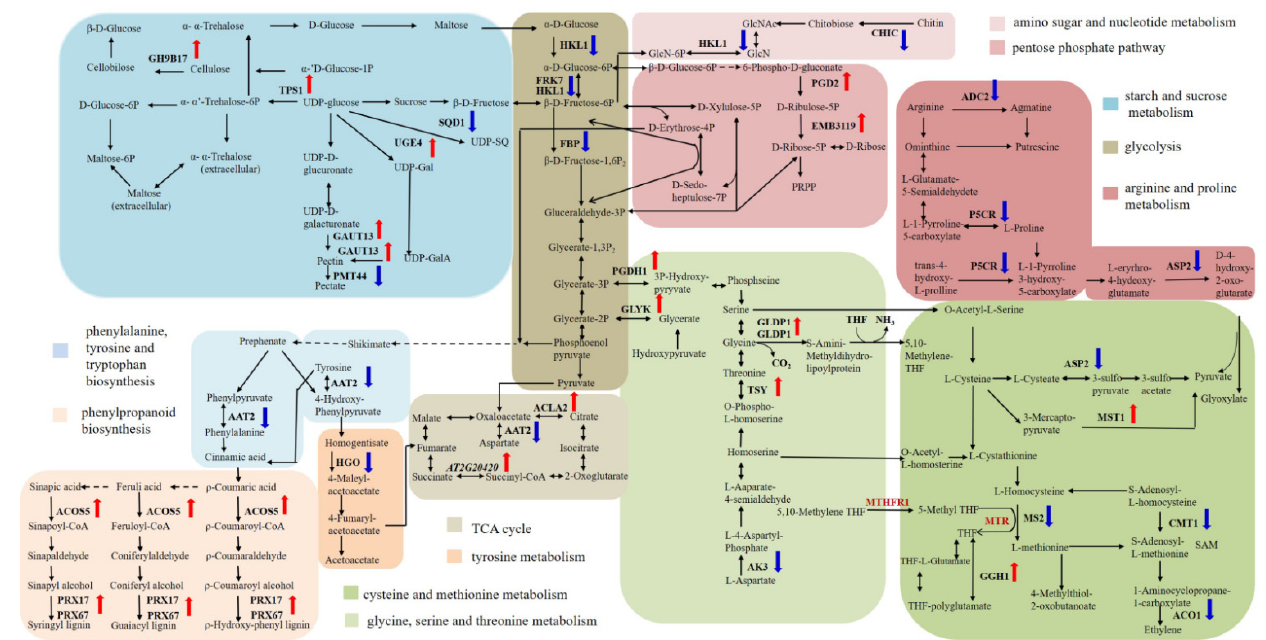
Figure 4. The distribution of the DEGs involved in KEGG pathways on B. napus genome. A01-A10 indicates 10 chromosomes of A genome in B. napus ; C01-C09 indicates 9 chromosomes of C genome in B. napus . Red dots indicate up-regulated genes and blue dots indicate down-regulated genes. Large dots indicate 30 DEGs closely related to lignocellulose synthesis.